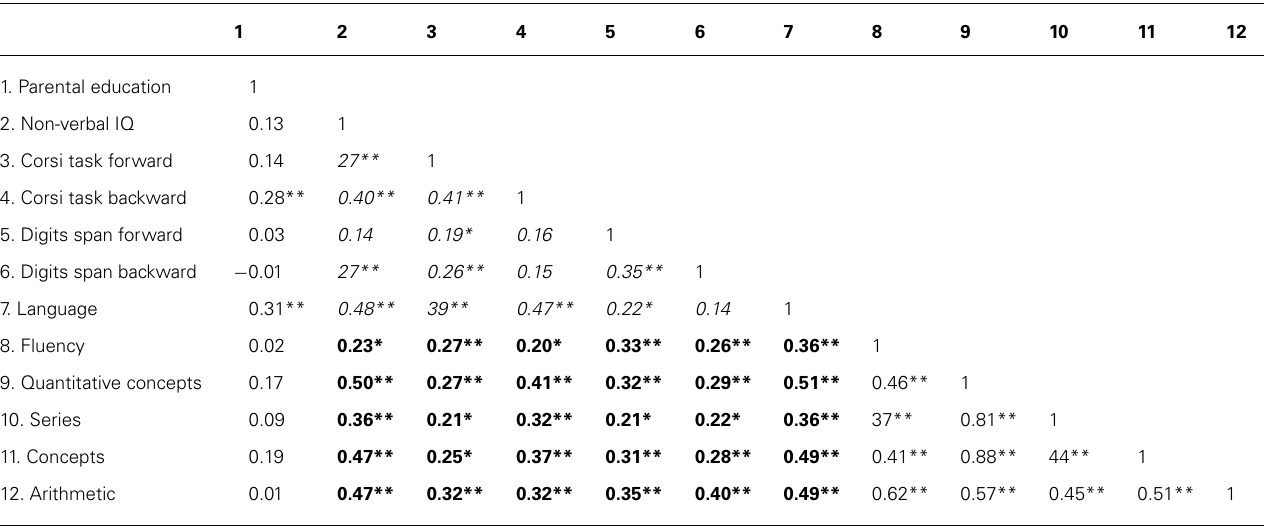
Table 3 | Correlations among all